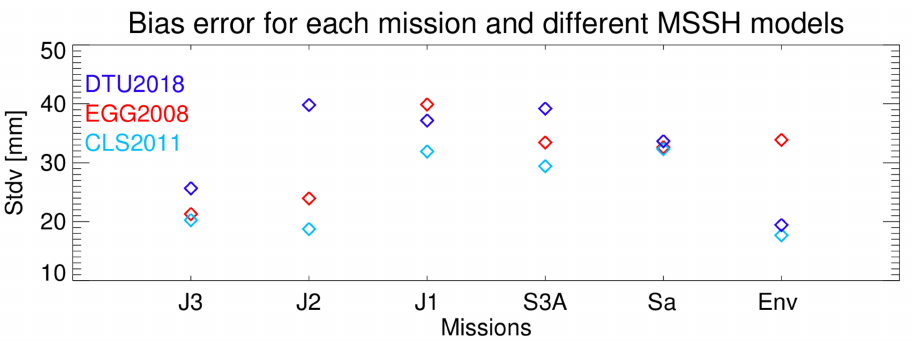
Figure 3. Standard deviation of (regional) mission biases for all station pairs with Jason-3 (J3), Jason-2 (J2), Jason-1 (J1), Sentinel-3A (S3A), Saral (Sa) and Envisat (Env) for three different models of the SSH (color coded). The number of collocated station pairs depends on the mission (3–8, cf. Table